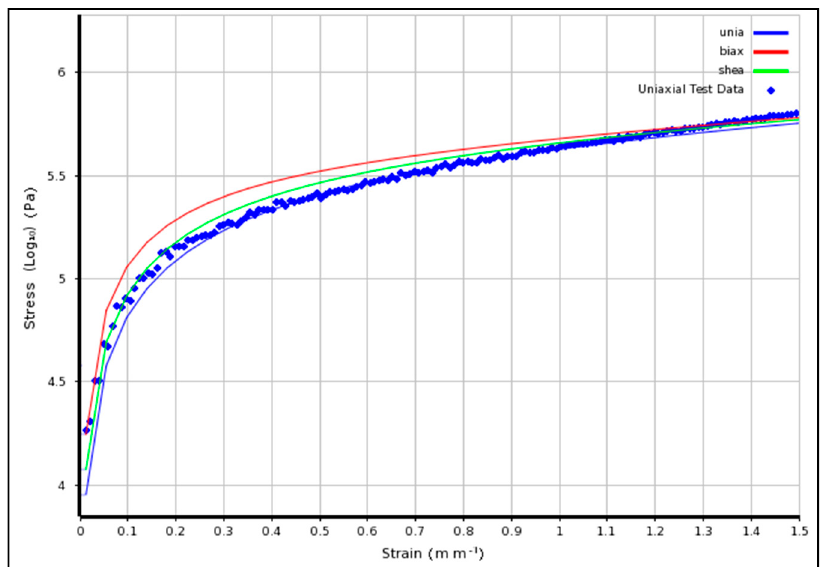
Figure 6. EPDM material—Neo-Hookean hyperelastic model fitted to uniaxial experimental data.